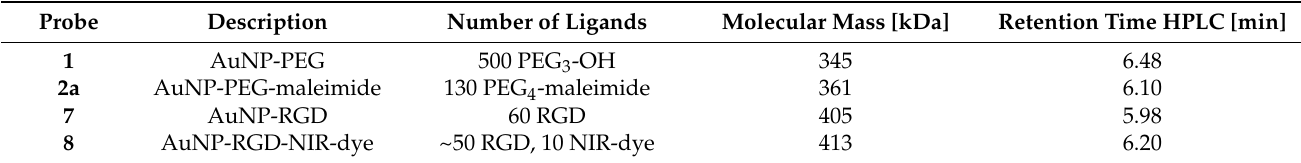
Table 1. Calculated number of ligands and resulting molecular mass of the AuNPs and retention in HPLC. Probe